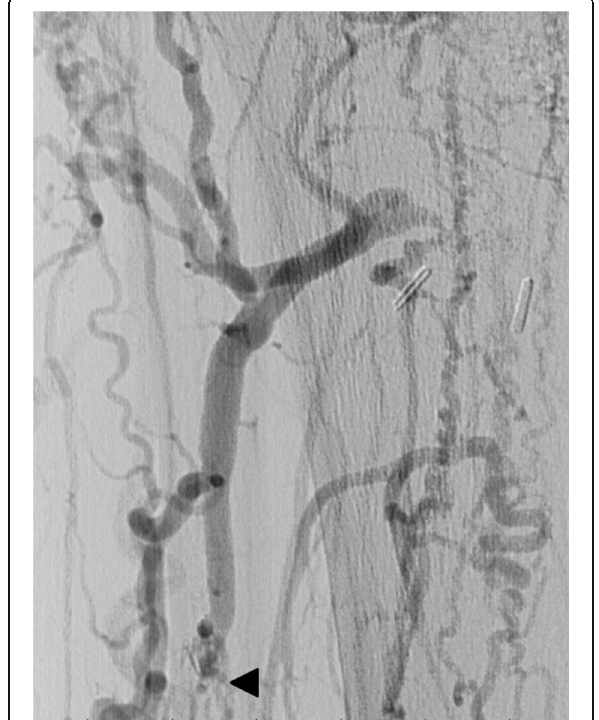
Fig. 2 Magnified view at the level of the proximal anterior tibial artery which looks recanalised by collaterals coming from branches of the deep femoral artery and then occluded few centimetres after its origin (arrow head). No flow is seen in the popliteal